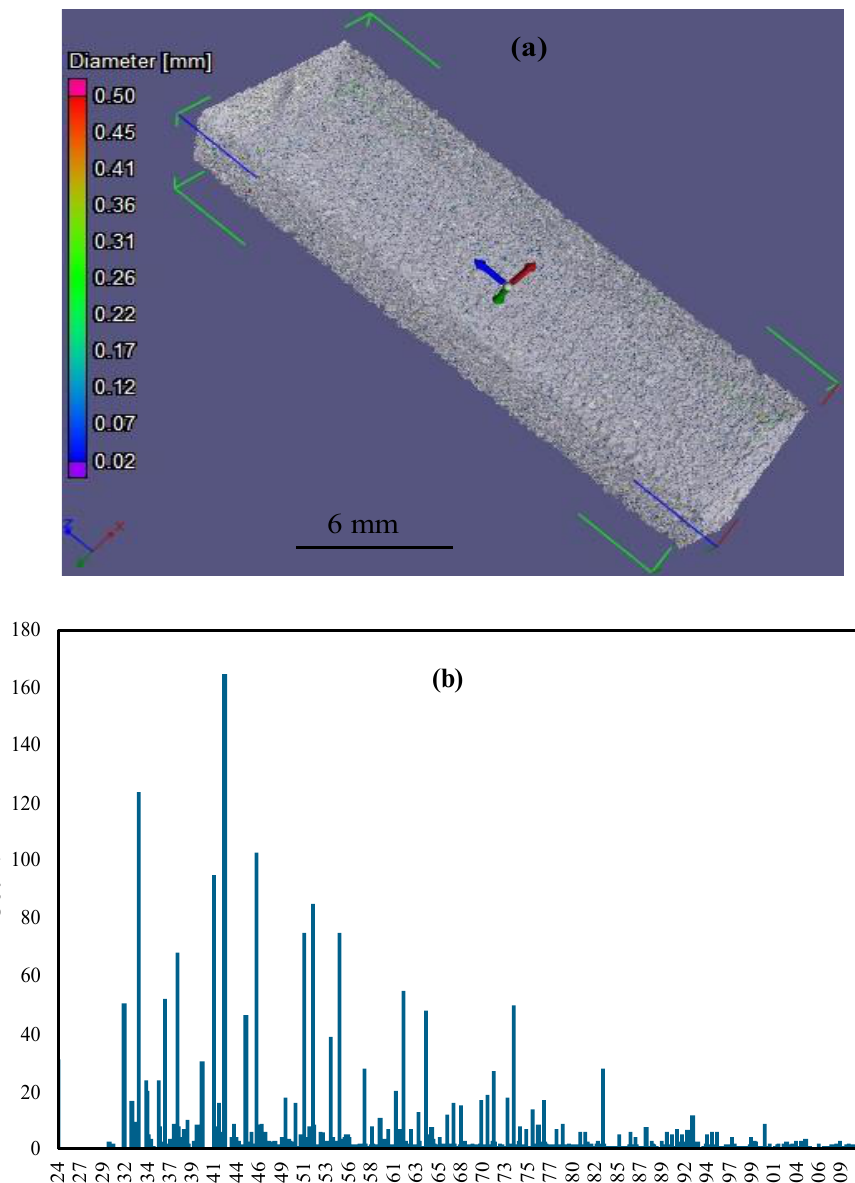
Figure 4. Defect distribution on the side-built sample, obtained from X-ray CT analysis: ( a ) 3D defect distribution inside the sample, and ( b ) frequencies of the distributed defects.